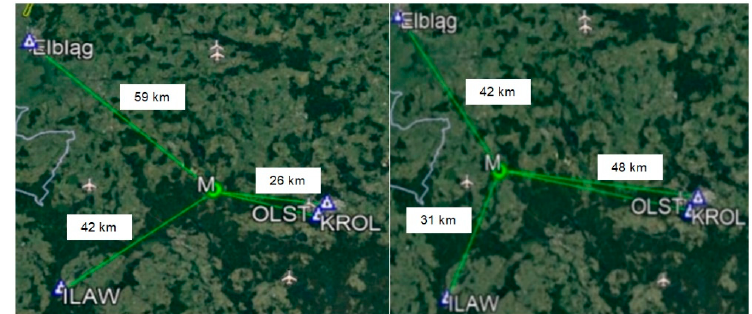
Figure 1. Arrangement of the reference stations of the ASG-EUPOS network during the differential global positioning system (DGPS) test measurements.